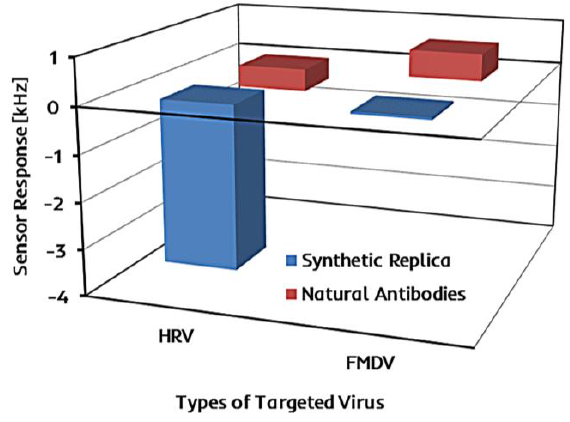
Figure 5. A comparison of the sensor response of natural antibodies and their synthetic replica prepared via imprinting for human rhinovirus (HRV) and foot-and-mouth disease virus (FMDV) recognition. HRV is the template as well as the target analyte, while FMDV is used for cross-sensitivity measurements. Reproduced with permission from Schirhagl et al. [70]. Copyright by Wiley-VCH Verlag GmbH & Co. KGaA, Weinheim, 2009.